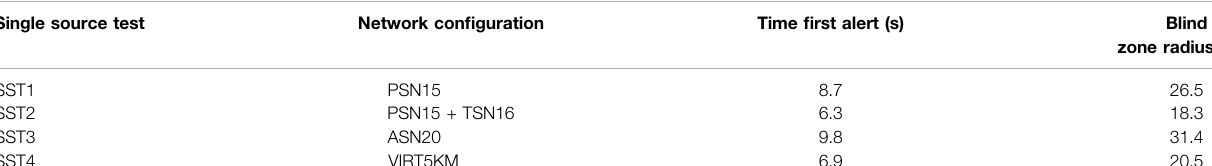
TABLE 5 | Results of tests with single source and different network con fi gurations.